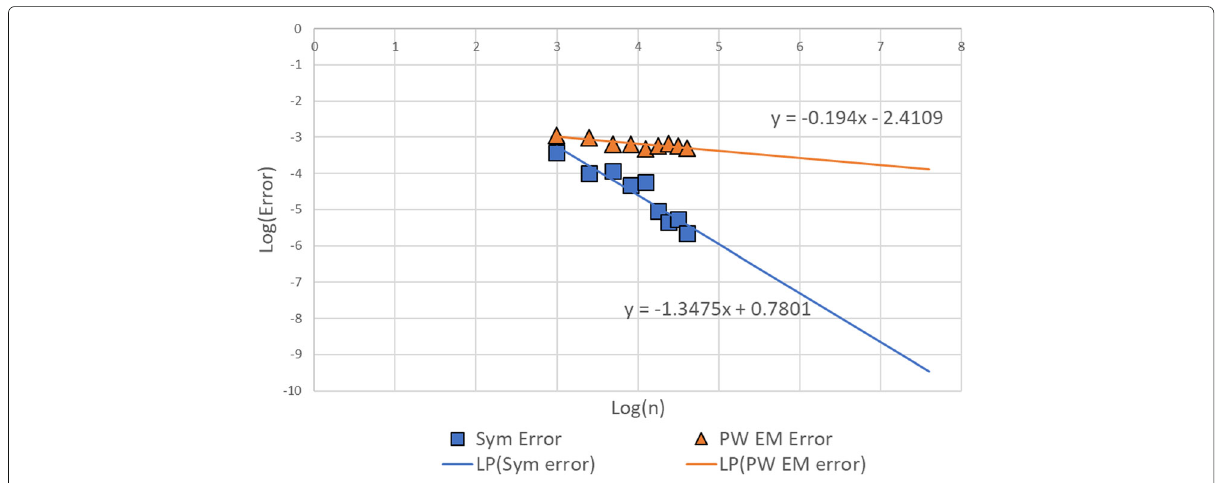
Fig. 2 The results of the second experiment